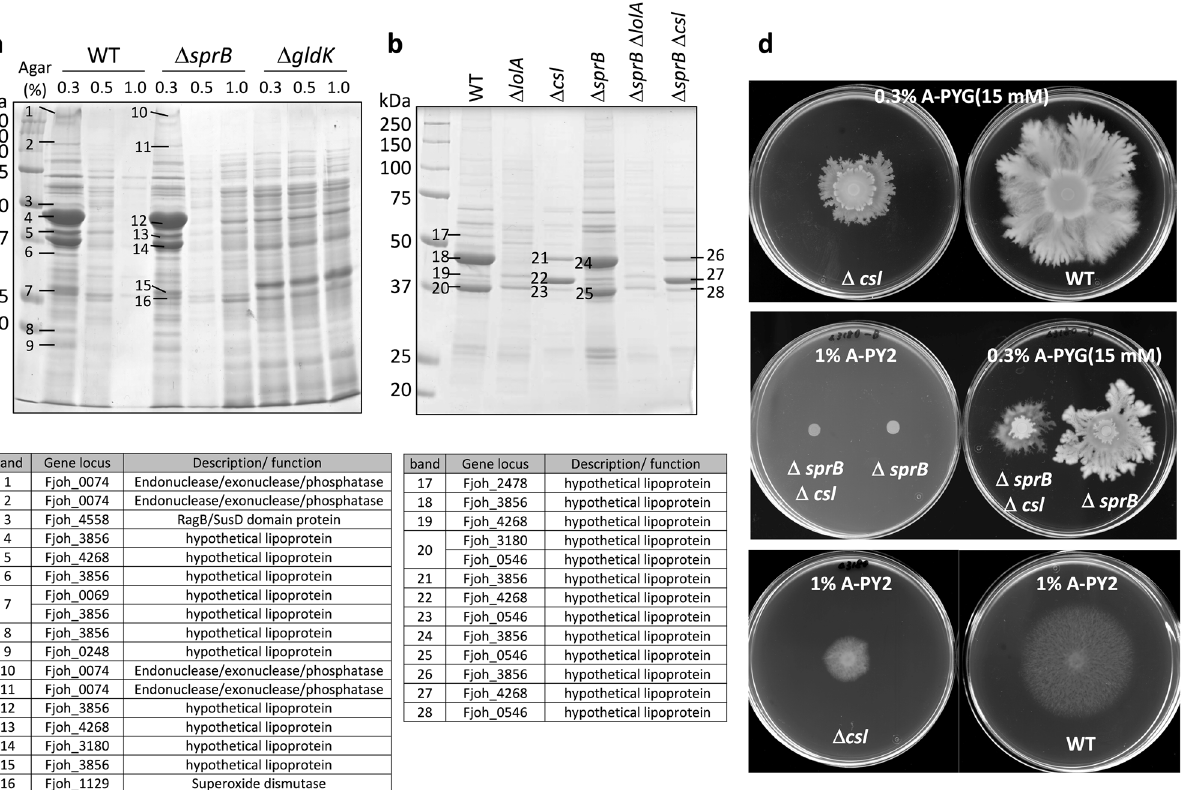
Figure 5. SDS-PAGE analysis of the lipoproteins essential for colony spreading. ( a ) Comparison of the cell surface proteins of WT, Δ sprB and gldK F. johnsoniae on 0.3, 0.5 and 1% A-PYG (15 mM). Protein bands 1–16 were analyzed by peptide mass fingerprinting. A greater abundance of lipoproteins was present under colony expansion conditions on 0.3% A-PYG (15 mM) than under non-expansion conditions on 1% A-PYG (15 mM). ( b ) Comparison of the cell surface proteins of WT, Δ lolA , Δ csl , Δ sprB , Δ sprB Δ lolA and Δ sprB Δ csl F. johnsoniae on 0.3% A-PYG (15 mM). Protein bands 17–28 were analyzed by peptide mass fingerprinting. ( c ) Identification of protein bands present in the SDS-PAGE gel shown in sections a (band nos. 1–16) and b (band nos. 17–28) using mass spectrometry. ( d ) Colony spreading of WT, Δ csl, Δ sprB and Δ sprB Δ csl F. johnsoniae on 1% A-PY2 and 0.3% A-PYG (15